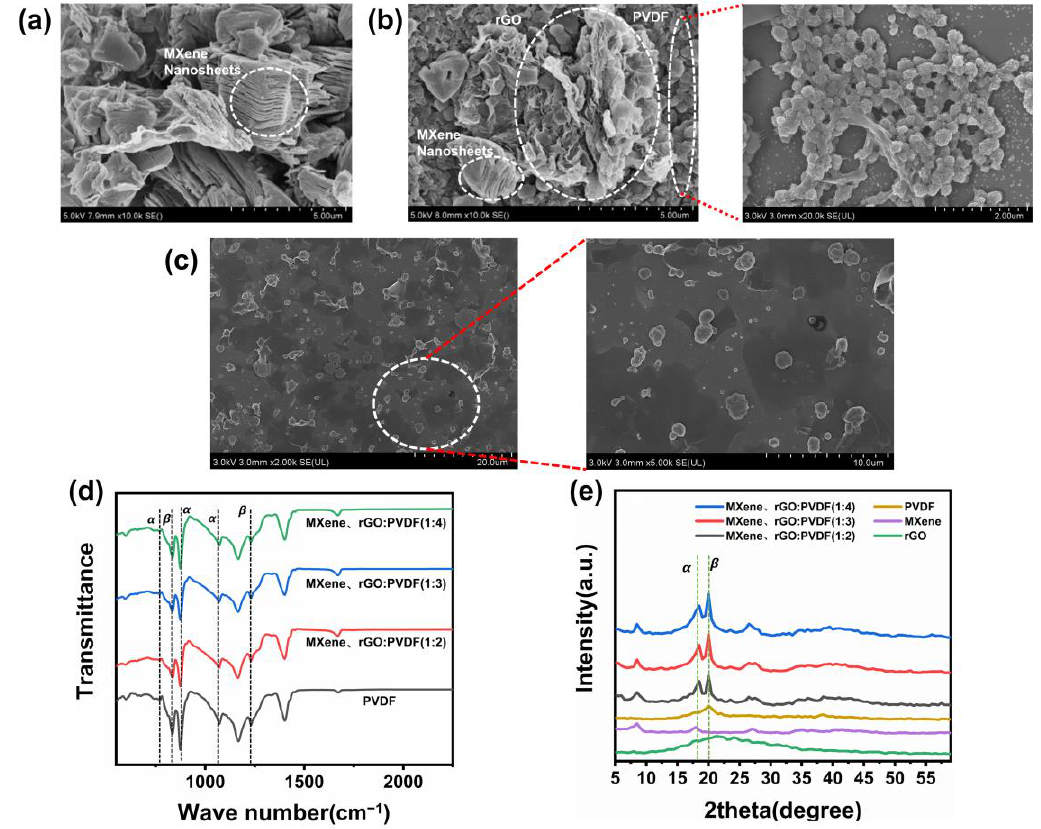
Figure 6. Characterization of the nanocomposite thin films. ( a ) SEM image of the MXene/rGO nanocomposite thin film surface. ( b ) SEM image of the PMR nanocomposite thin film surface. ( c ) Low magnification SEM image of the PMR nanocomposite thin film. ( d ) FTIR spectra of the PVDF, PVDF/MXene/rGO nanocomposite thin films. ( e ) XRD pattern of the PVDF, MXene, rGO, and PVDF/MXene/rGO nanocomposite thin films.